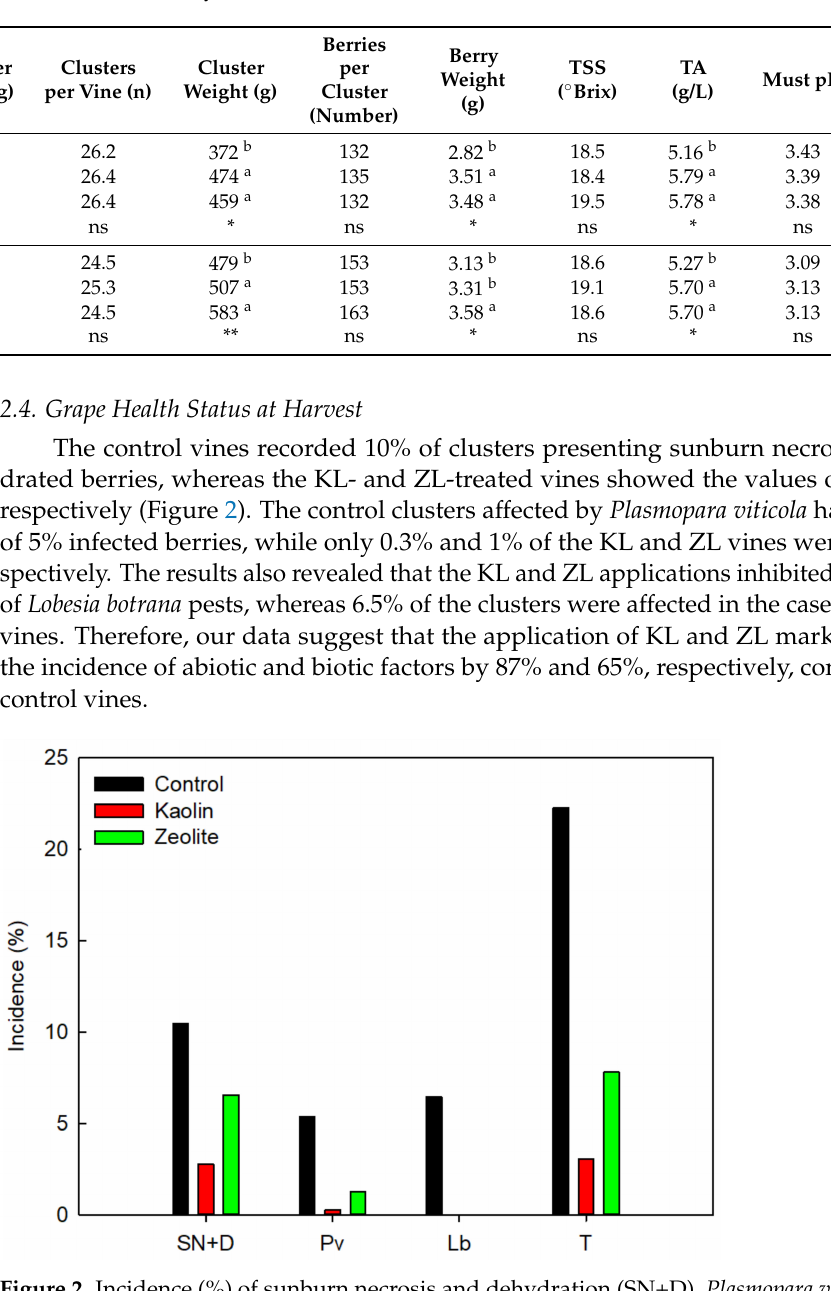
Table 3. Yield components, cluster characteristics, and fruit composition recorded on cv. Roditis grapevines subjected to canopy application of kaolin (KL) and zeolite (ZL), in comparison with untreated vines (control, C) in 2018 and 2019 at harvest. Values are presented as means ± SD. Mean values with different lowercase letters (a, b, c) represent significant differences between the treatments, in the same year. *, ** and ns represent significance at p ≤ 0.05, p ≤ 0.01 and no significant differences ( t -test), respectively. The interaction of year x treatment was not significant. TSS = total soluble solids; TA = titratable acidity.